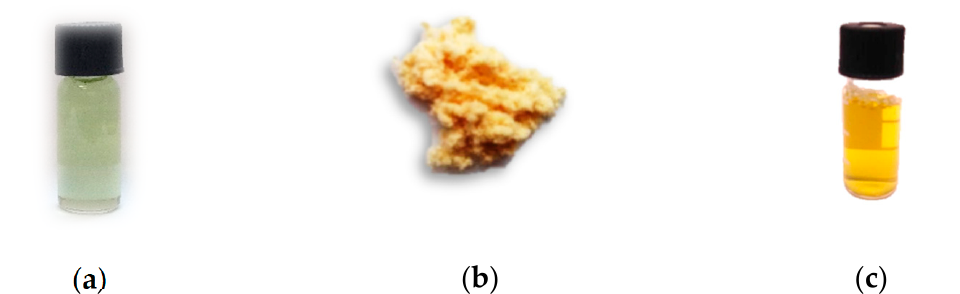
Figure 1. Images of components used in synthesis: ( a ) unsaturated polyester resin; ( b ) softwood flour; ( c ) silver nanoparticles concentrate.